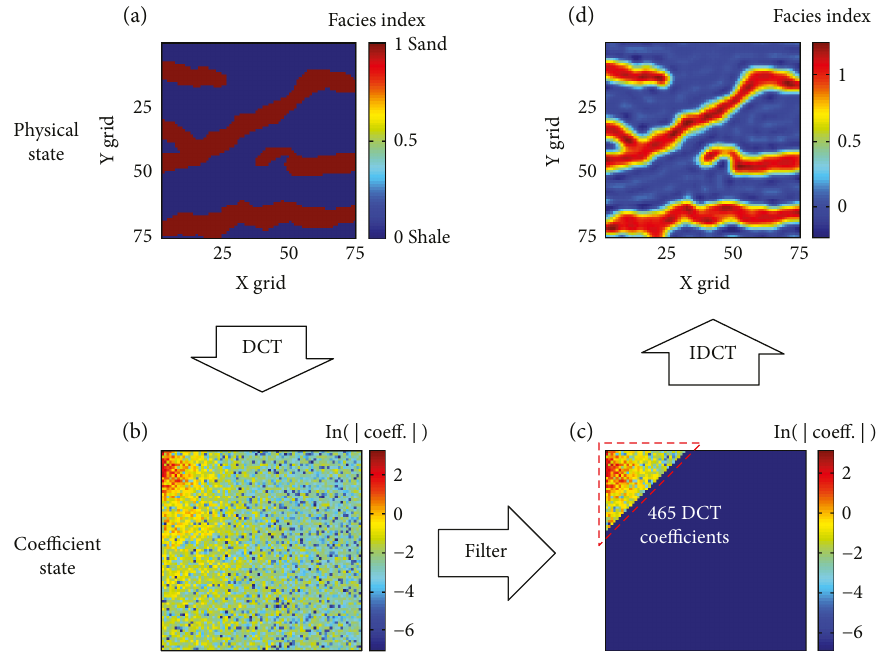
Figure 1: Example of discrete cosine transform (DCT) and inverse DCT (IDCT) applied to the reproduction of shale and sand facies of a channelized